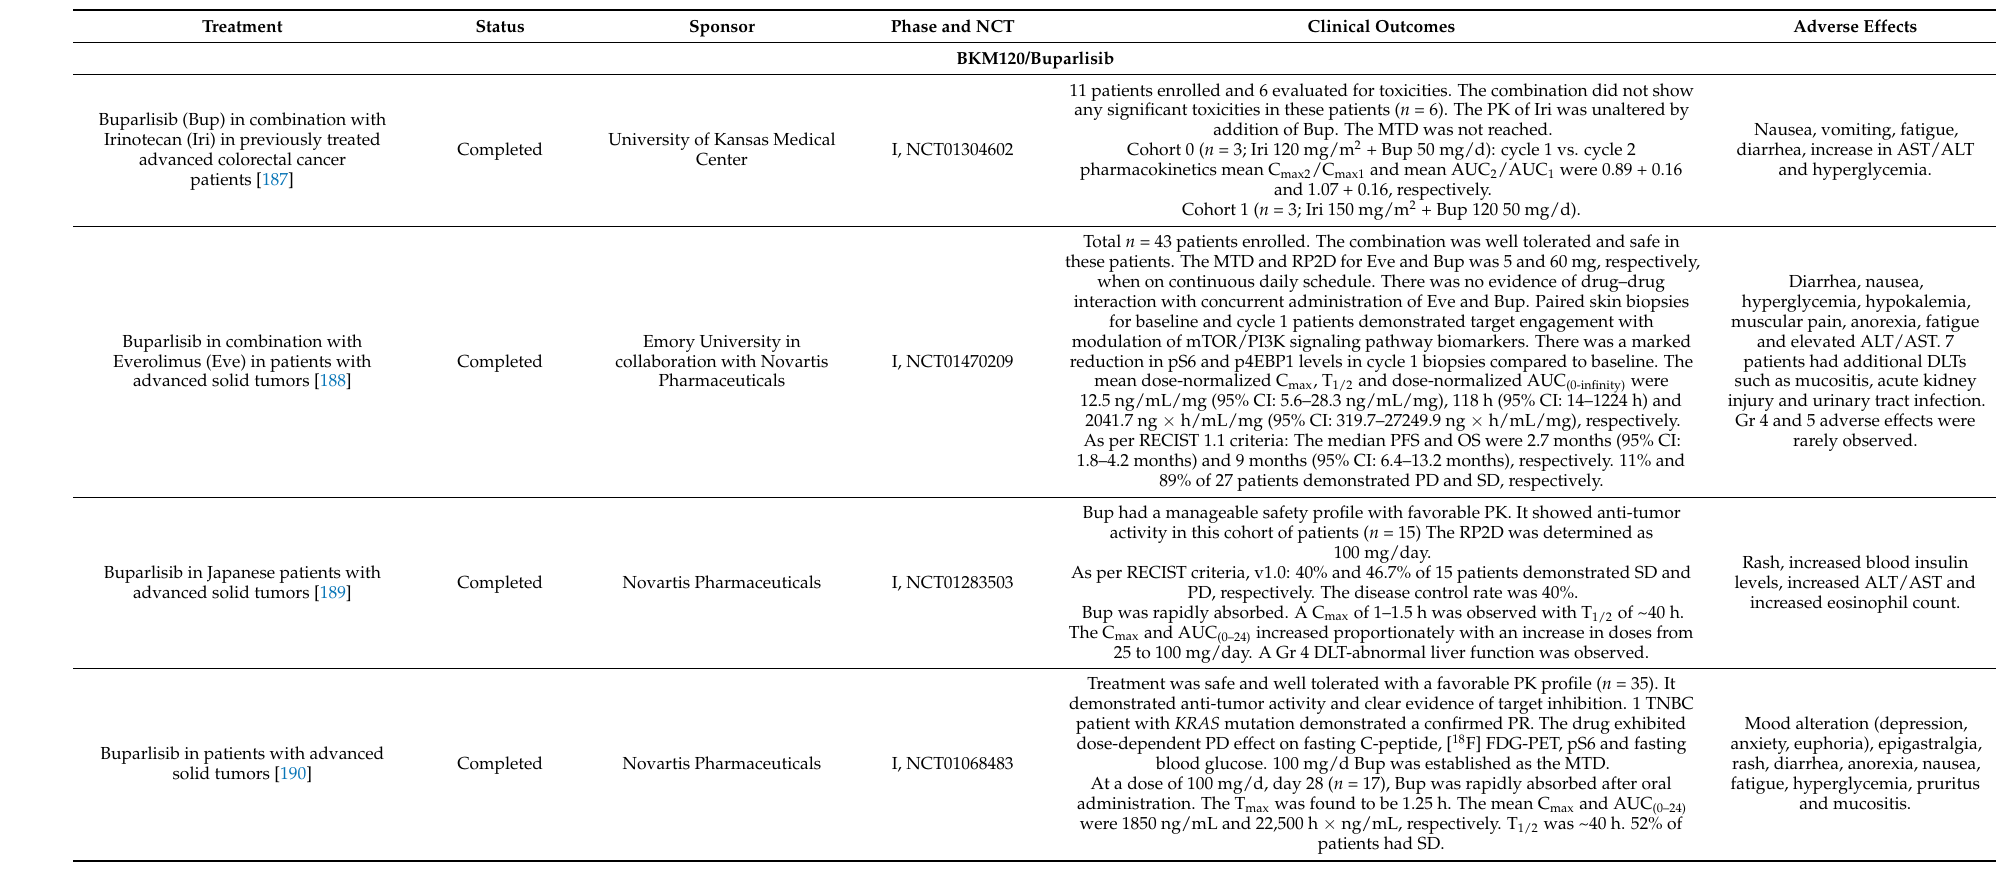
Table 1. Summary of trials, outcomes and adverse events associated with pan-PI3K inhibitors in various phases of clinical